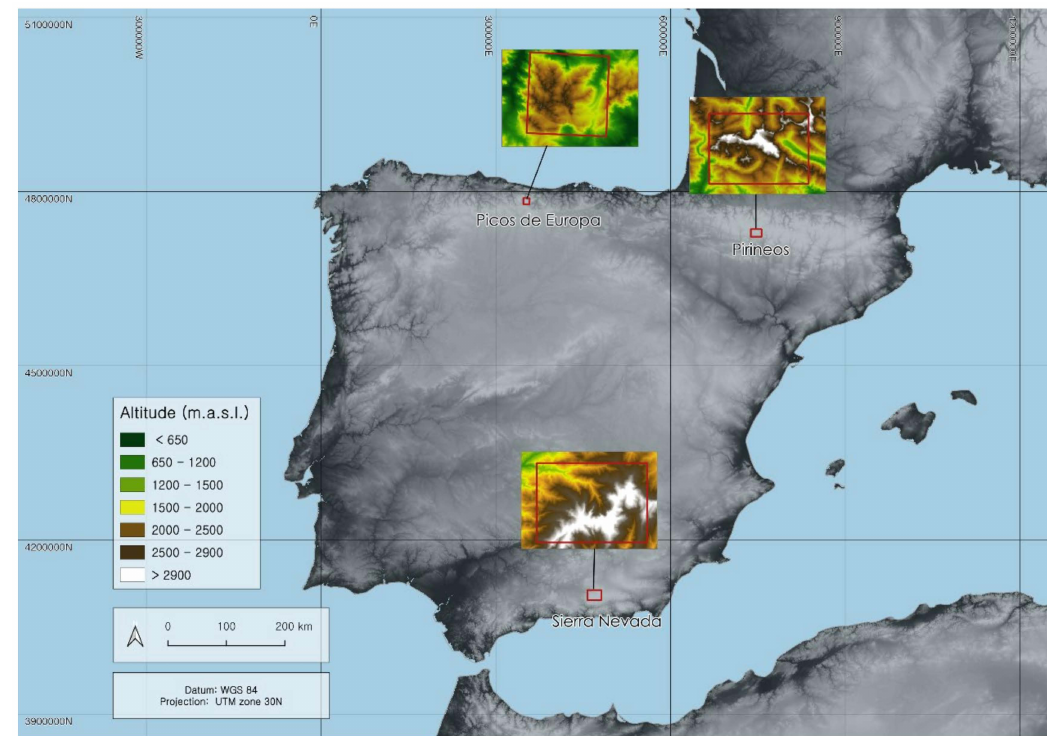
Figure 1. Digital Elevation Models (DEM) of the study areas, and location of these sites within the Iberian Peninsula DEMs from the Instituto Geogr á fico Nacional (Spanish National Geographic